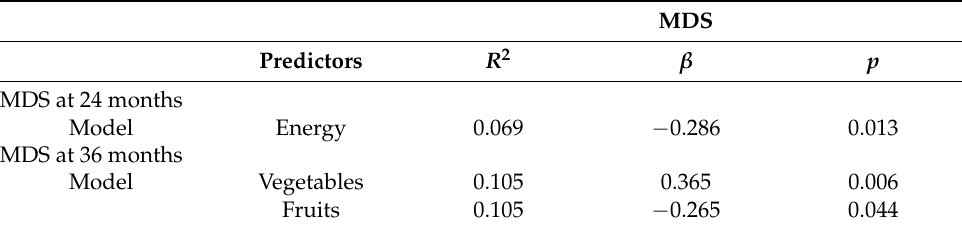
Table 4. Linear association between diet at 6 months and the Mediterranean Diet Score (MDS) at 24 and 36 months.